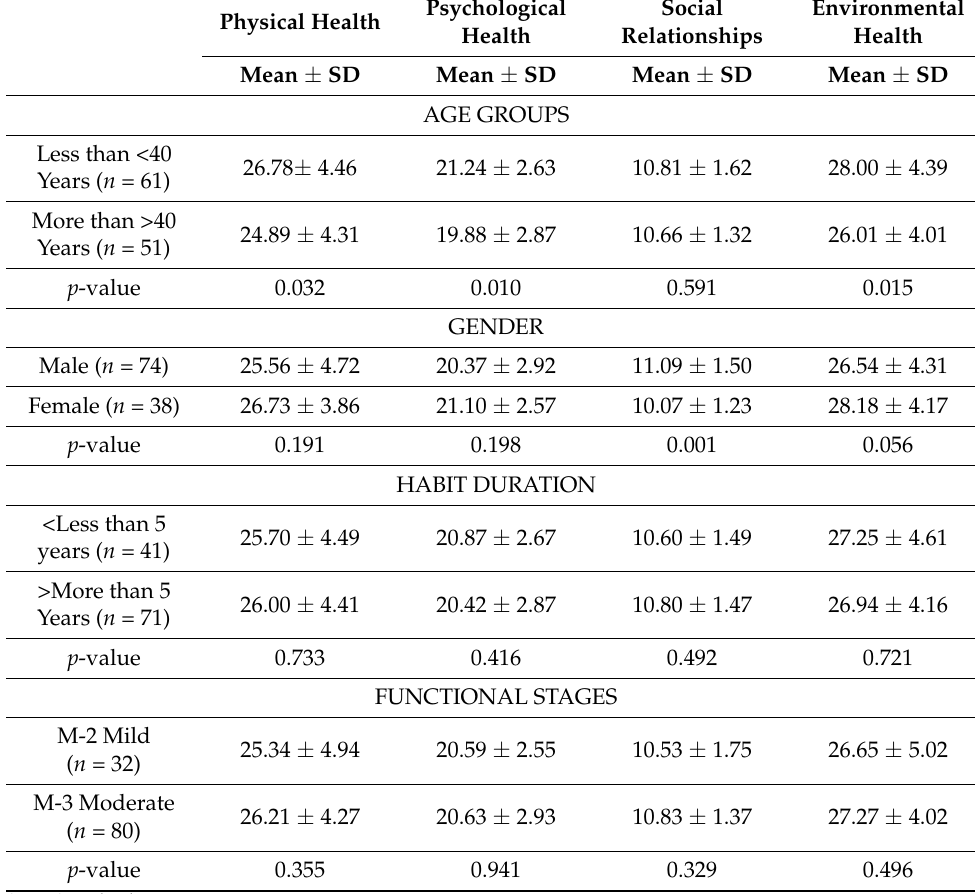
Table 1. Difference in mean scores of age groups, gender, habit duration, and functional stages with four domains of life by Student’s t